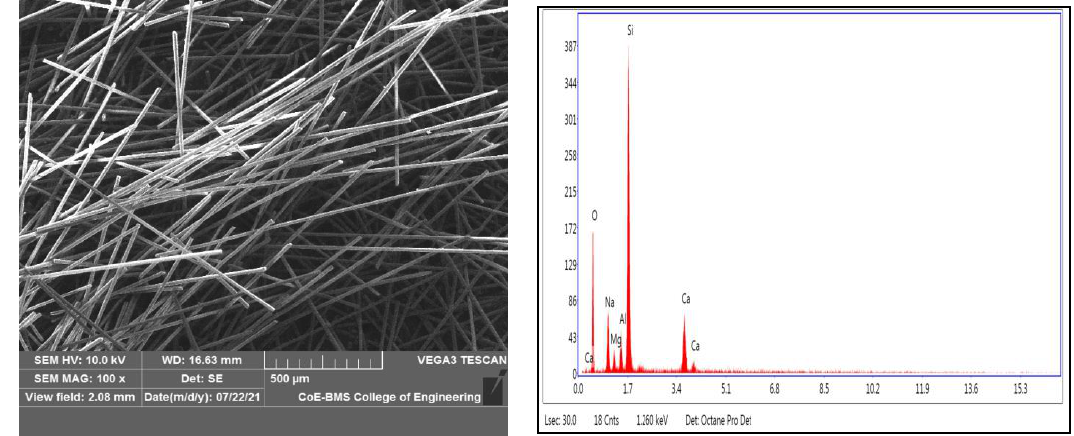
Figure 2. Photograph of as received ( a ) short glass fibre and ( b ) ABS pellets.